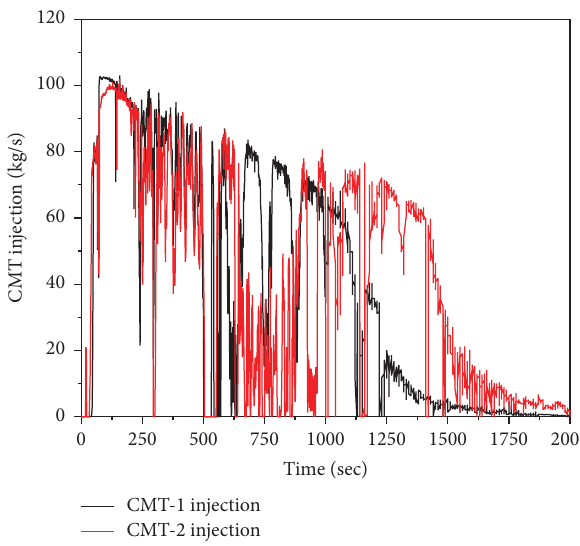
Figure 9: Comparison of CMTs flow rate in